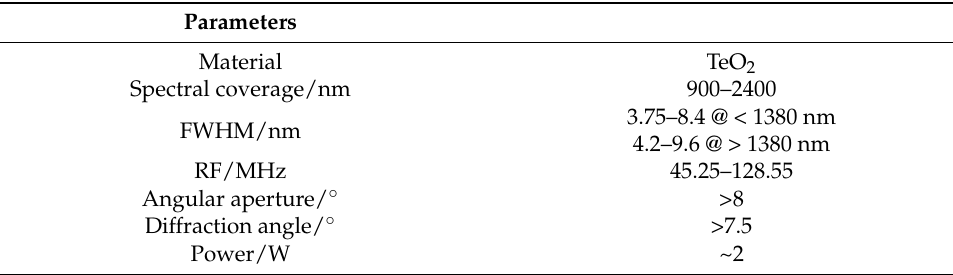
Figure 3. AOTF detection system and testing process. ( a ) schematic diagram of AOTF dual optical path and dual detector NIR spectrometer; P1, P2, polarizer; BS, adjustable beam splitter; D1, D2, InGaAs photodetector; ( b ) flow chart of AOTF detection based on AutoML. Table 1. The main performance parameters of the